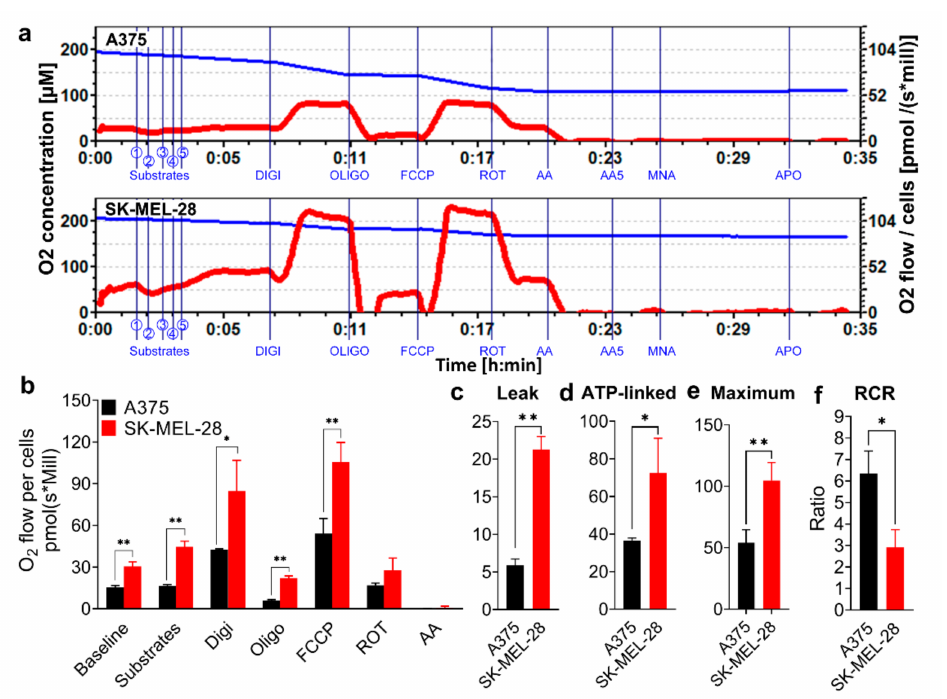
Figure 1. Comparative mitochondria phenotypes in melanoma cell lines. A375 and SK-MEL-28 cells were counted and placed in the Oroboros respiratory chambers, with sequential injections of Cx I and Cx II substrates ( 1 (cid:13) L-glutamate; 2 (cid:13) L-malic; 3 (cid:13) ADP; 4 (cid:13) pyruvate; 5 (cid:13) succinate), Digi (8.1 mM), Oligo (5 mM), FCCP (1 mM), ROT (1 mM), and AA (5 mM). ( a ) The O 2 concentration (blue line) and OCR for per million A375 and SK-MEL-28 cells (red line) were monitored in real-time. ( b ) The stable OCR values for per million A375 and SK-MEL-28 cells, measured by Oroboros, are displayed in the bar graph ( n = 3). The data accessed from Oroboros was further calculated. The results are shown as ( c ) proton leak, ( d ) ATP-linked respiration, ( e ) maximum respiration, and ( f ) RCR, which means the State 3 over State 4 oligo. Results are expressed as mean ± SD. * p < 0.05, ** p < 0.01. Cx I, complex I; Cx II, complex II; ADP, adenosine diphosphate; Digi, digitonin; Oligo, oligomycin; FCCP, carbonyl cyanide-4-(trifluoromethoxy) phenylhydrazone; ROT, rotenone; AA, antimycin A; OCR, oxygen consumption rate; ATP, adenosine triphosphate; RCR, respiratory control ratio; SD, standard